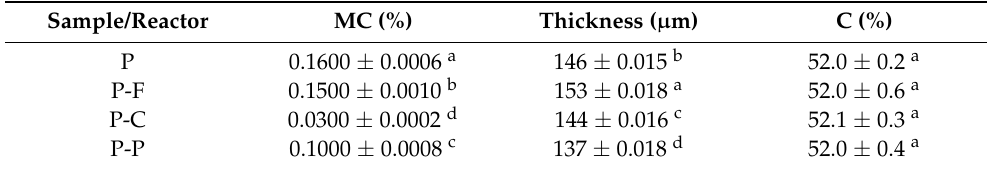
Table 1. Moisture content (MC), thickness and elemental carbon (C%) of the films prior to the composting test. PLA-PHBV blend films (P) and PLA-PHBV blend films containing ferulic acid (P-F), p -coumaric acid (P-C) and protocatechuic acid (P-P). Mean values and standard